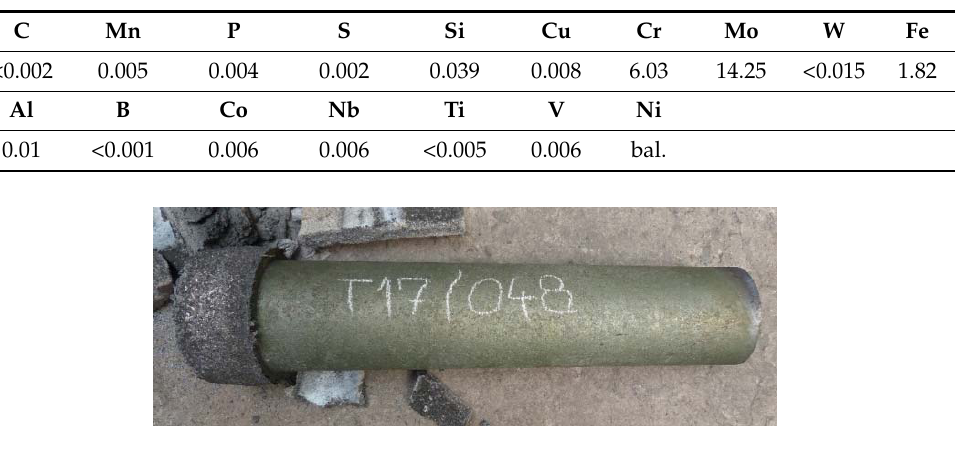
Table 3. Mechanical properties of nickel-based